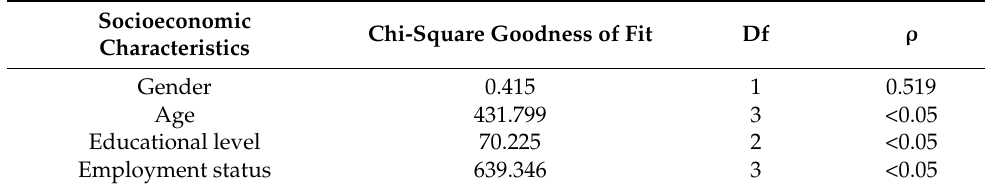
Table 5. Chi-square goodness of fit test for shared e-scooter users and potential users in Braga (N =